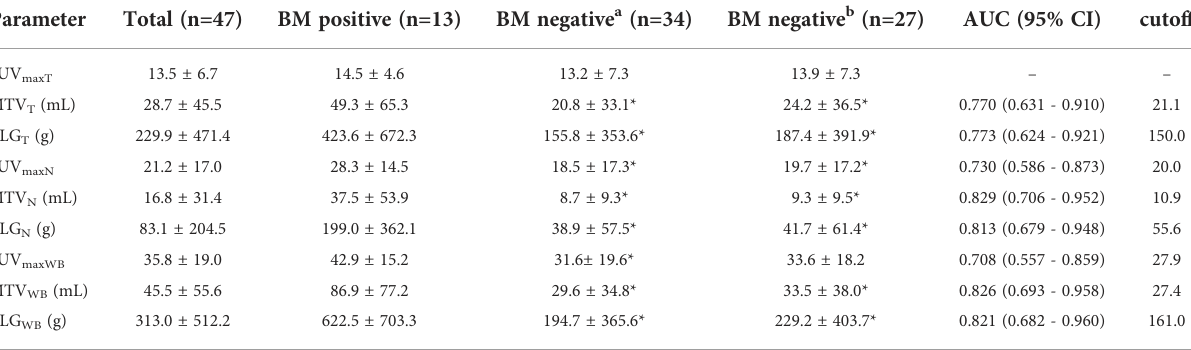
Values are presented as number or Mean ± SD. a Patients without BM from the whole study population. b Patients without BM from all recurrences. Compared the difference in PET parameter values between the BM-positive and BM-negative groups (Mann – Whitney U test). *P <0.05.